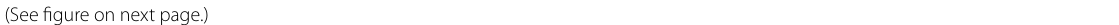
(See figure on next page.) Fig. 5 Correlation between bacterial and eukaryotic communities of Cephalotes hosts. A Regularized Generalized Canonical Correlation Analysis (rGCCA) correlation network between bacterial (16S rRNA) and eukaryotes (18S rRNA) communities associated with Cephalotes samples. Positive correlations are represented by red edges, and negative correlations by blue edges. B Heatmap indicating the positive (red) and negative (blue) correlations between the bacterial and eukaryotic communities of Cephalotes samples. The bacterial and eukaryotic ASVs were grouped according to the similarity of the correlations, as seen with the